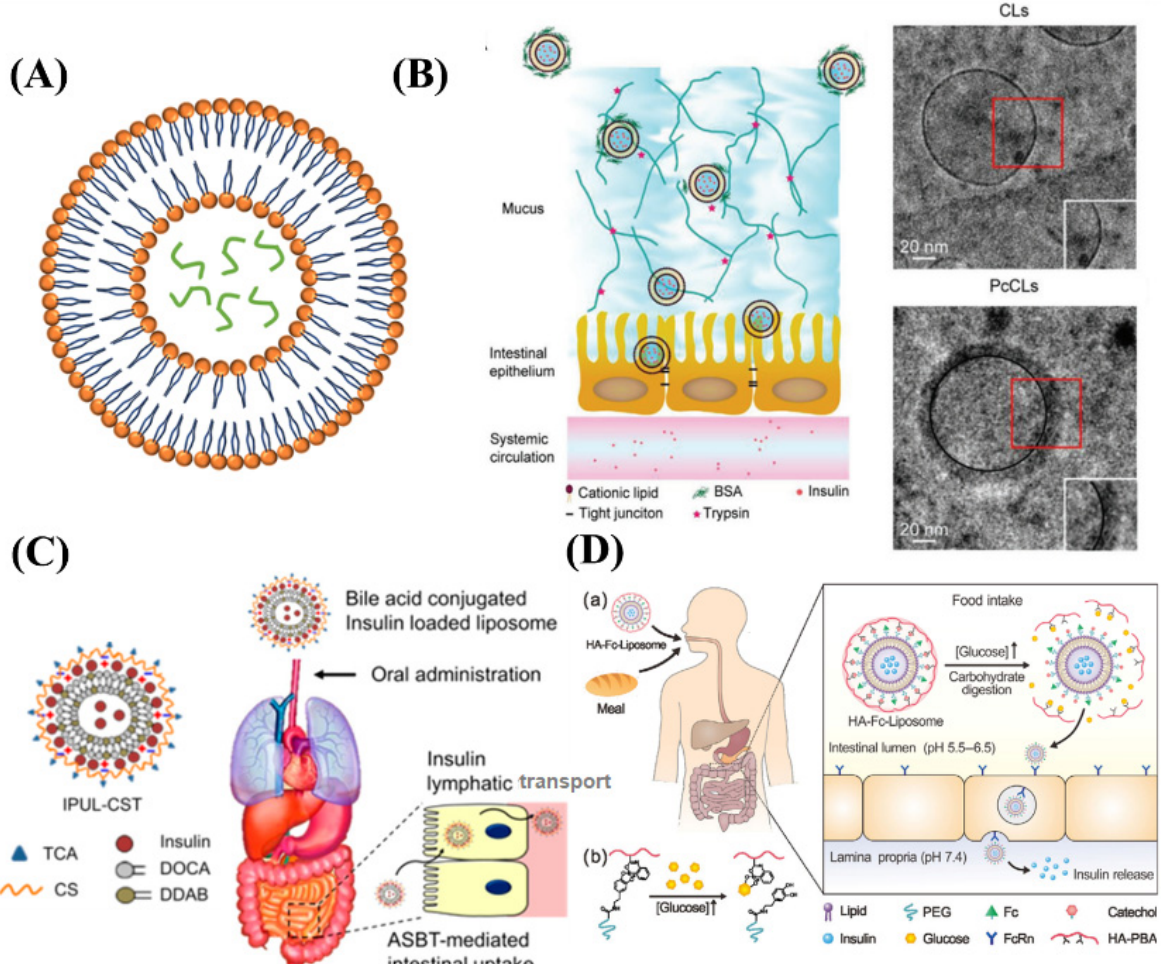
Figure 3. ( A ) The structure of liposomes. ( B ) TEM images of CLs and PcCLs, and schematic diagram for the process of the transport of the PcCLs through the mucus layers and epithelial barrier. ( C ) Schematic diagram of IPUL-CST and its intestinal uptake and lymphatic transport. ( D ) Schematic representation of the glucose-responsive oral insulin delivery liposomes for postprandial glycemic